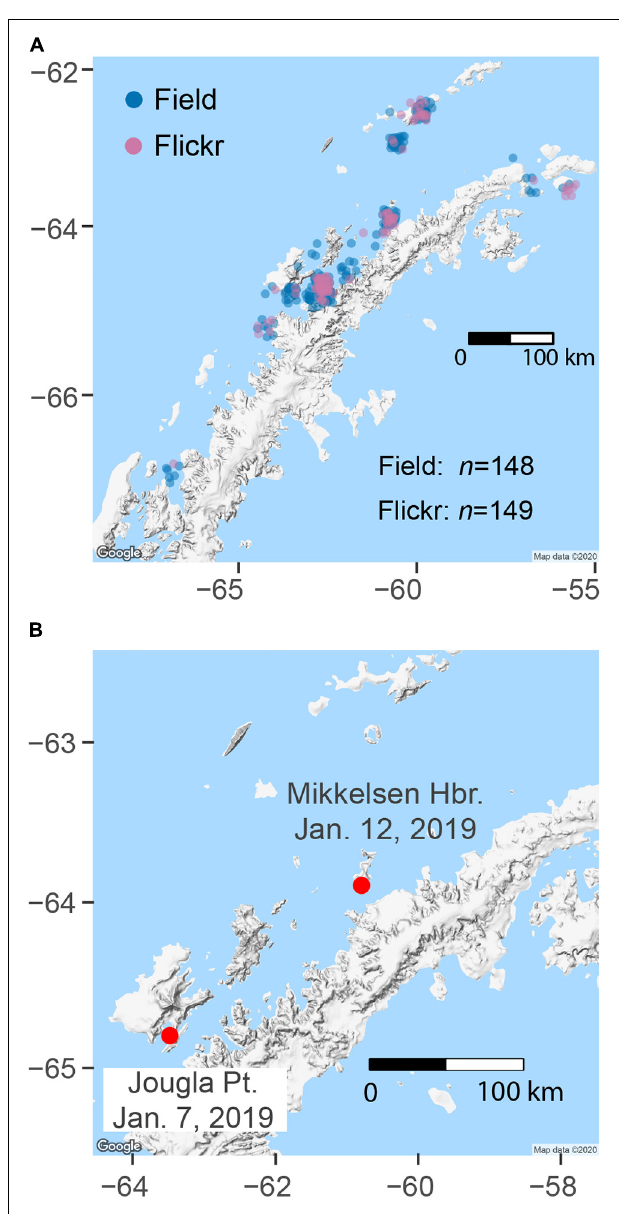
FIGURE 4 | (A) Locations of field-collected and web-scraped Weddell seal images. (B) Longest within-season travel for an individual, from Jougla Point in the south to Mikkelsen Harbor in the north (167-km straight-line